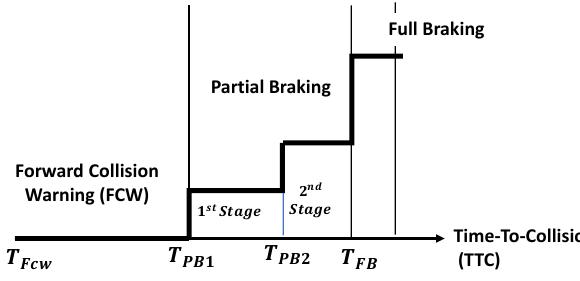
Figure 7. The AEB system ’ s cascaded braking.